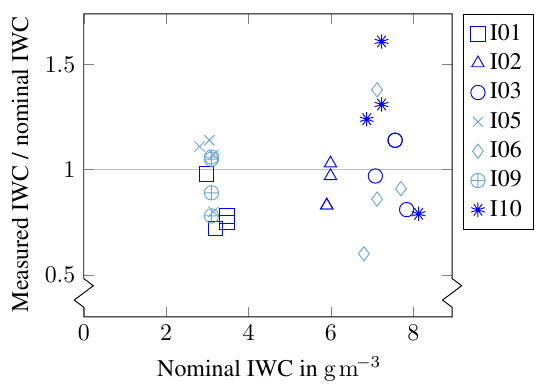
Figure 27. Results of the probe intercomparison between 2D-S (LAMP), 2D-S (DLR), M-HSI and C-HSI for seven different test points at glaciated icing conditions.